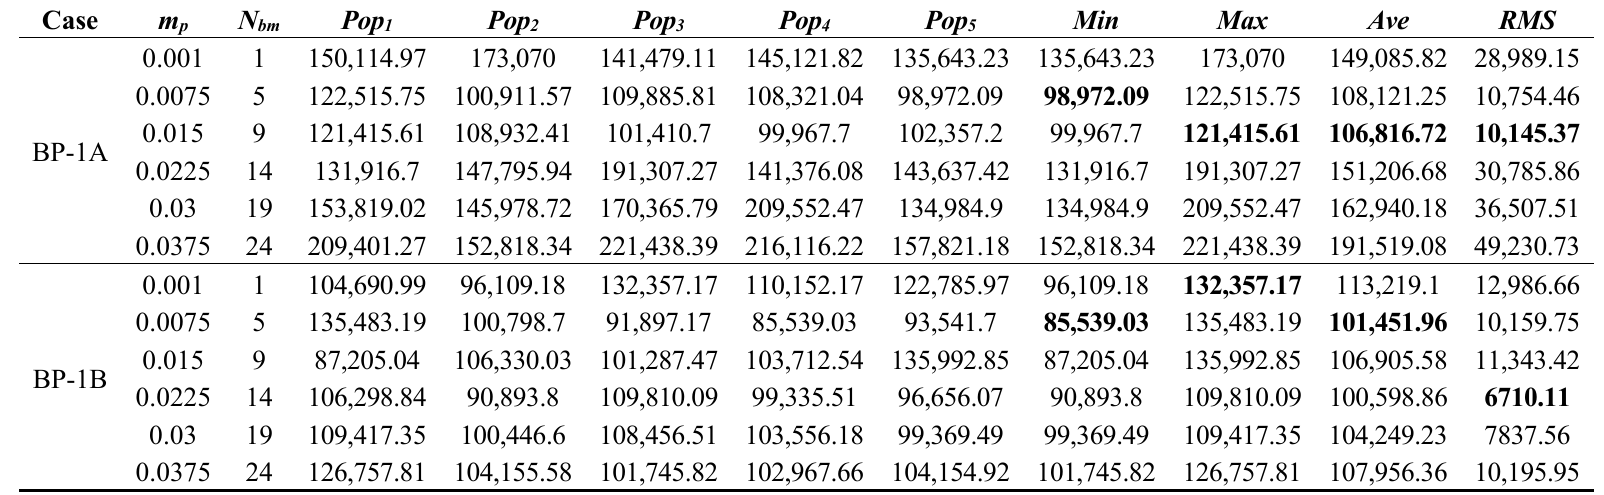
Table 7. Biggiero and Pianese (1996) [64] case study. Optimal results for the cases BP-1A and BP-1B.